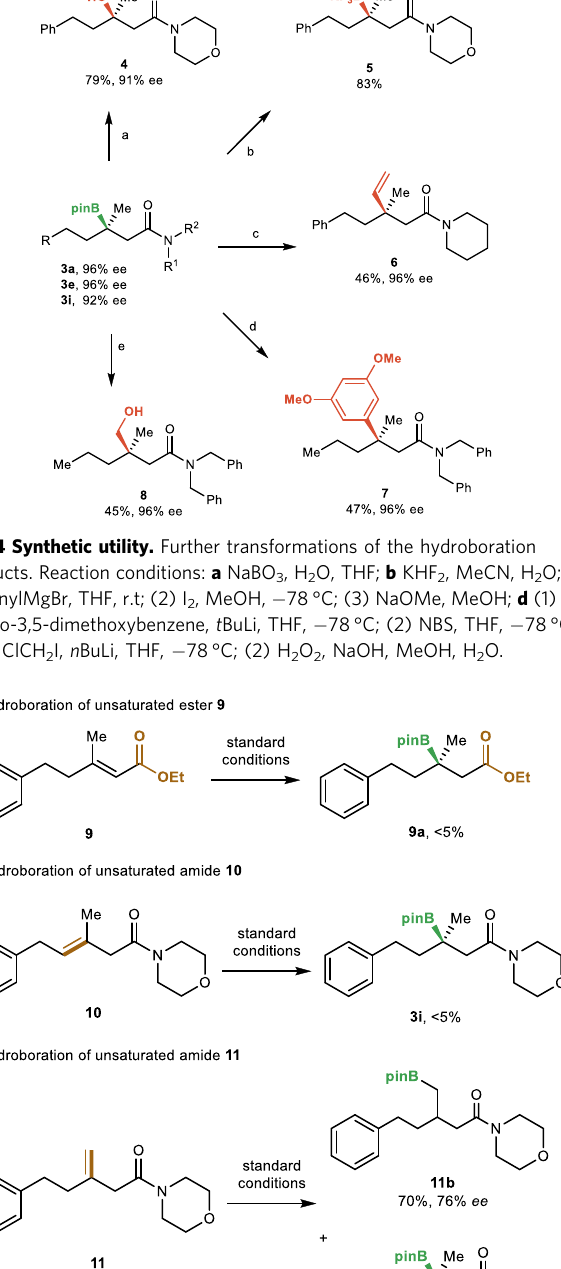
Fig. 7 Structures of competing transition states. Transition state structures leading to major enantiomer ( TS-2 ) and minor enantiomer ( TS-2 ′